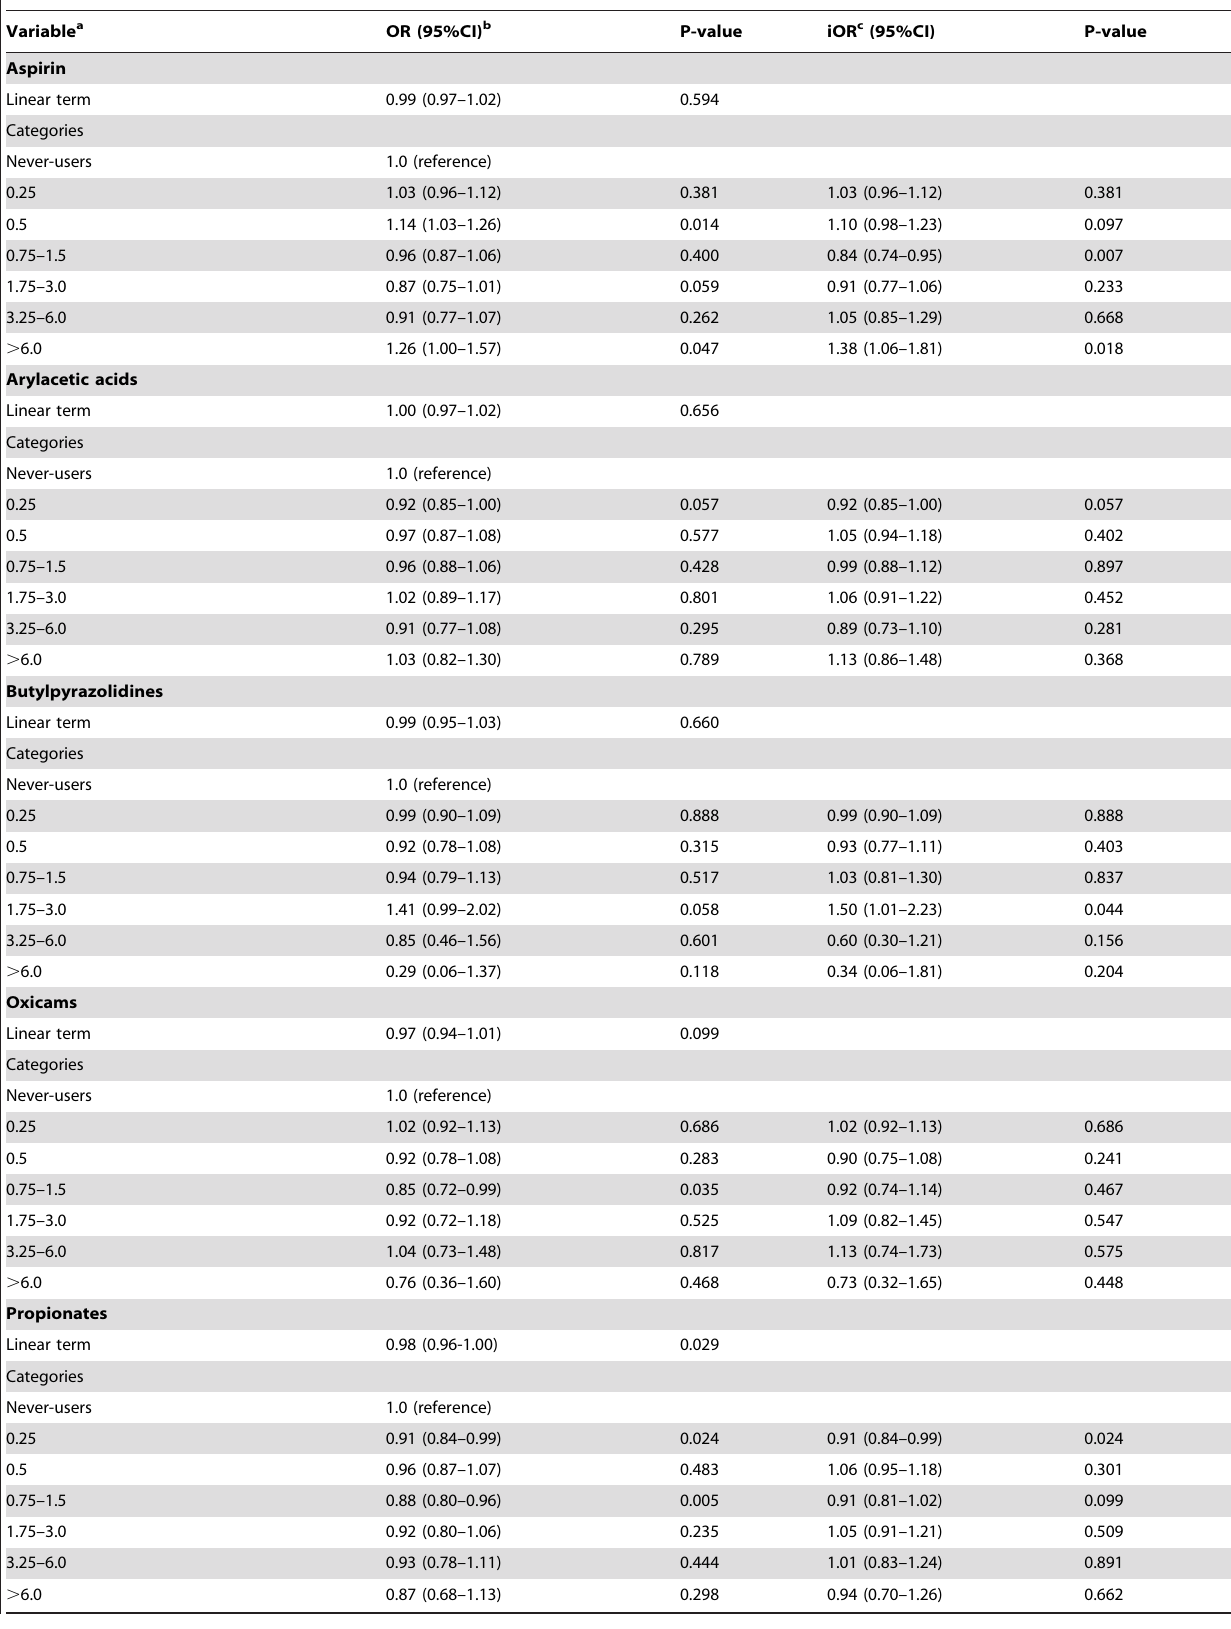
Table 5. Effect of duration of NSAID prescriptions (in years) on the risk of developing prostate